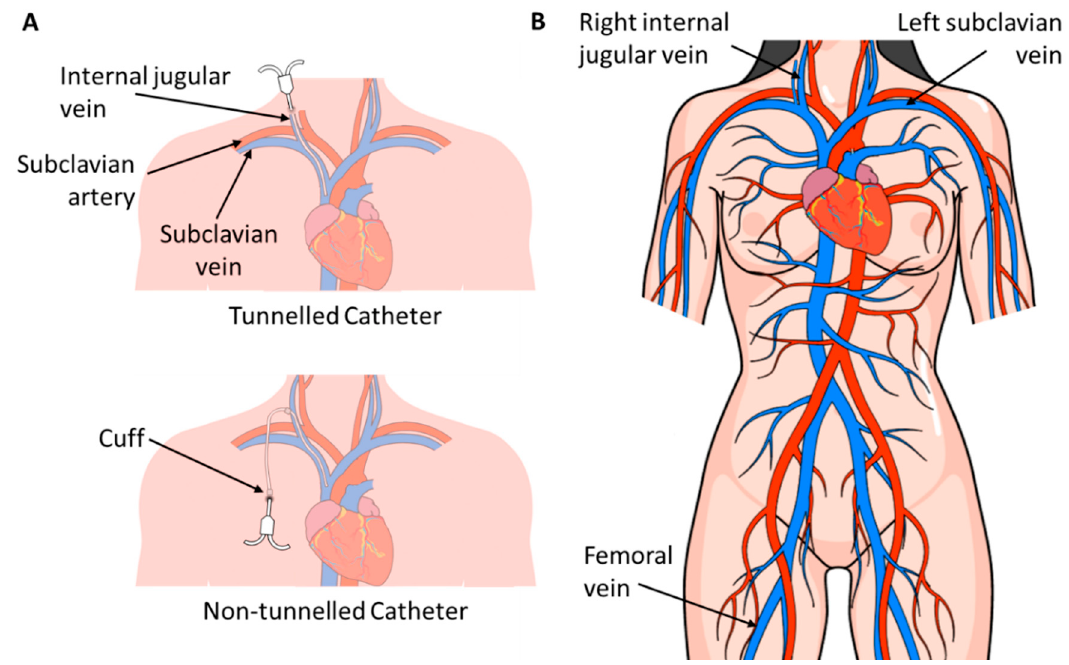
Figure 1. ( A ) Tunnelled catheter and non-tunnelled catheter. ( B ) Catheter Insertion